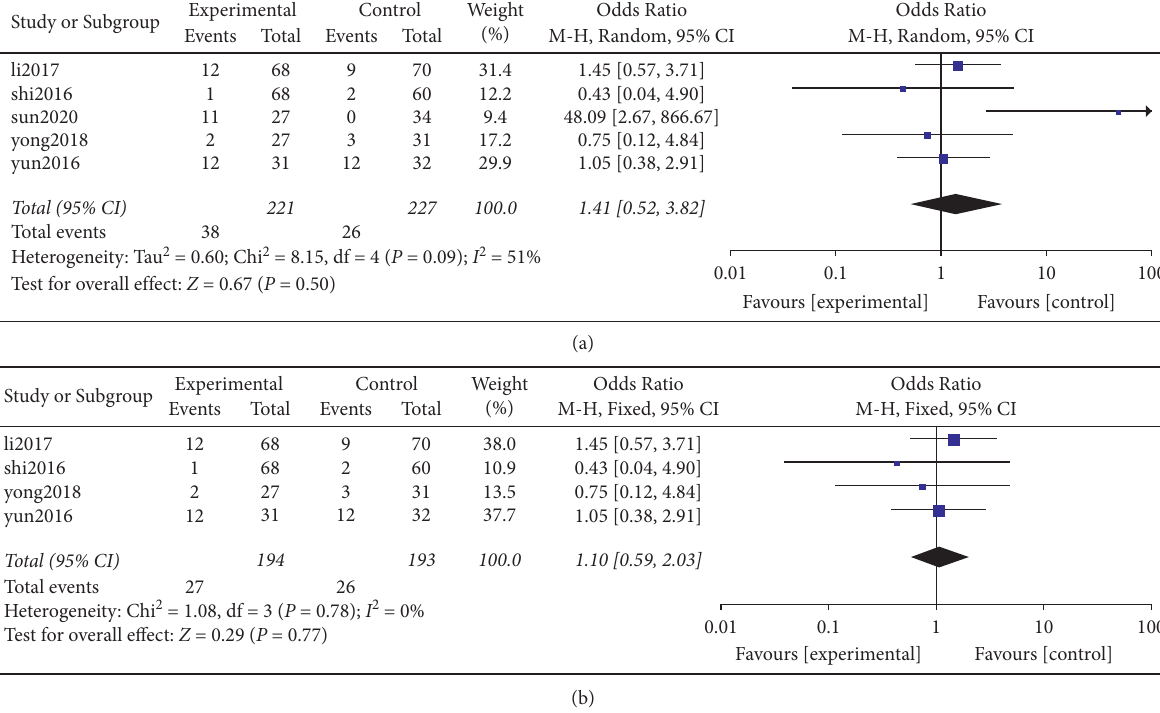
Figure 11: (a) Fusion sinking rate after surgery. (b) Sensitivity analysis of fusion sinking rate after operation. Experimental Study or Subgroup